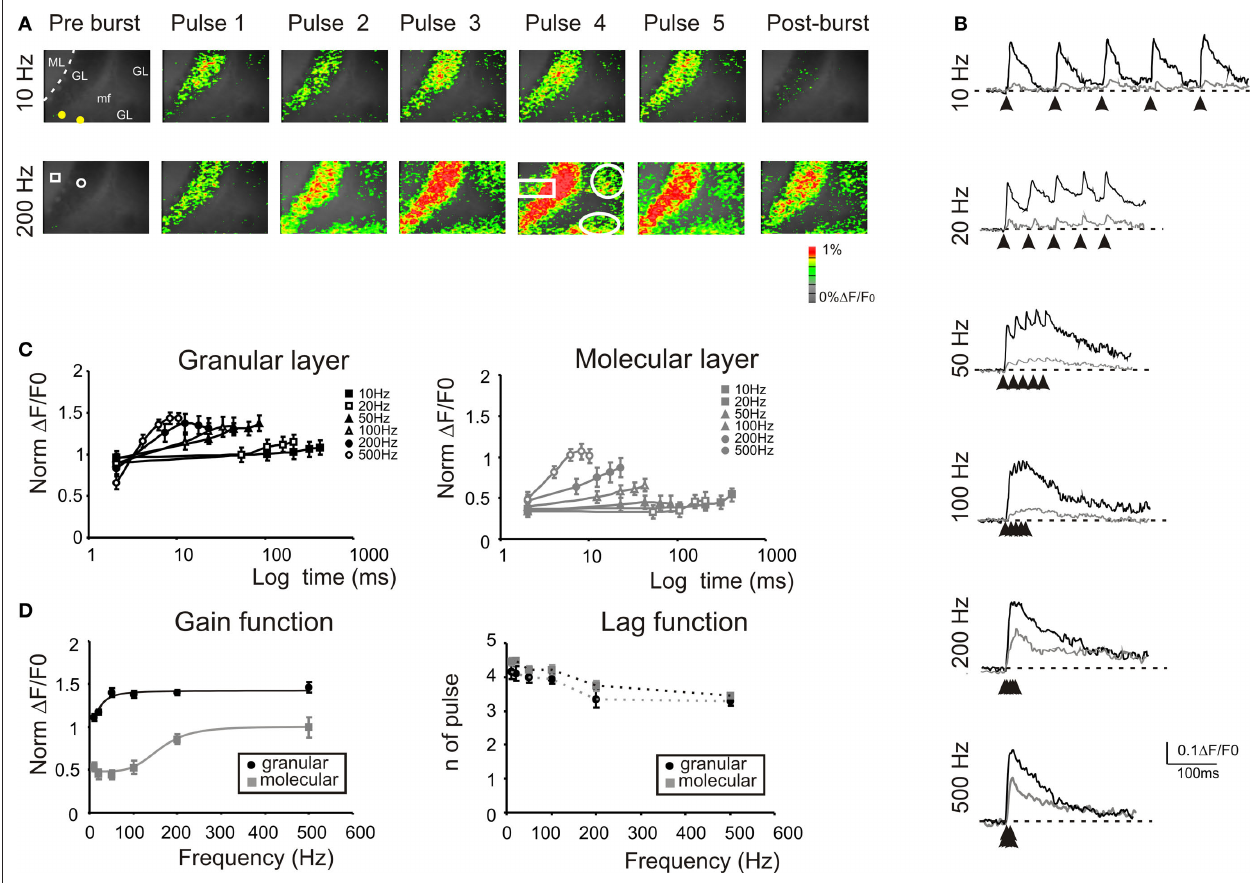
layer (gray). Note the much stronger molecular layer response at higher frequencies and the consistent temporal summation of all signals. (C) Maximum response amplitudes were measured for each of the five pulses of bursts delivered at different frequencies in the granular (black; n = 8 slices, n = 32 ROIs for each frequency) and in the molecular layer (gray; n = 8 slices, n = 28 ROIs for each frequency). Points are reported as mean ± SEM. (D) Gain and lag curves for granular (black; n = 8 slices, n = 32 ROIs for each frequency) and molecular layer (gray; n = 8 slices, n = 28 ROIs for each frequency) responses. Gain is the maximum response obtained at a certain frequency and lag is the number of pulses needed to achieve the maximal response. The gain curves were fitted a sigmoidal function (Eq.1). Points are reported as mean ±